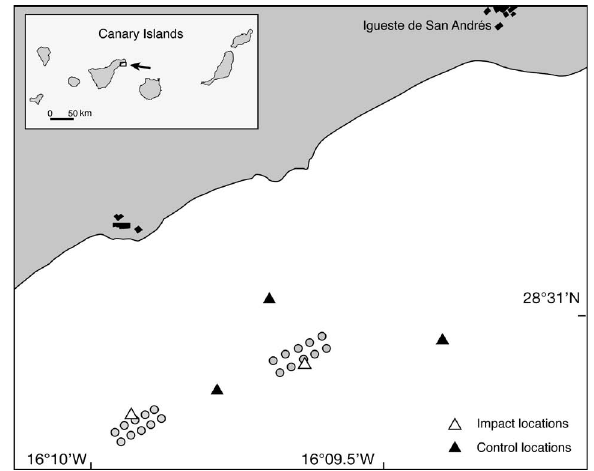
Fig. 1. – Map of the study area showing sampling